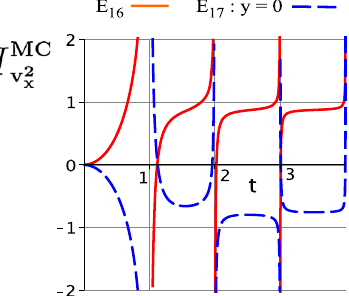
Fig. 3 Time evolution of the x -component of the orientability indi- cator in units of p 2 / m 2 for a point electric dipole oriented in the flip y -direction in Minkowski spacetime with orientable E 16 and non- orientable E 17 spatial topologies, both with compact length a = 1. The solid and dashed lines stand, respectively, for the indicator curves for a dipolein3-spacewith E 16 and E 17 topologies.Forthegloballyinhomo- geneous topology E 17 the dipole is at P 0 = ( x , 0 , z ) , thus freezing out thetopologicalinhomogeneity.Bothorientabilityindicatorcurvesshow a periodicity, but the curve for E 17 exhibits a different kind of period- icity characterized by a distinctive inversion pattern. Non-orientability is responsible for this pattern of successive inversions, which is absent in the indicator curve for the orientable E 16